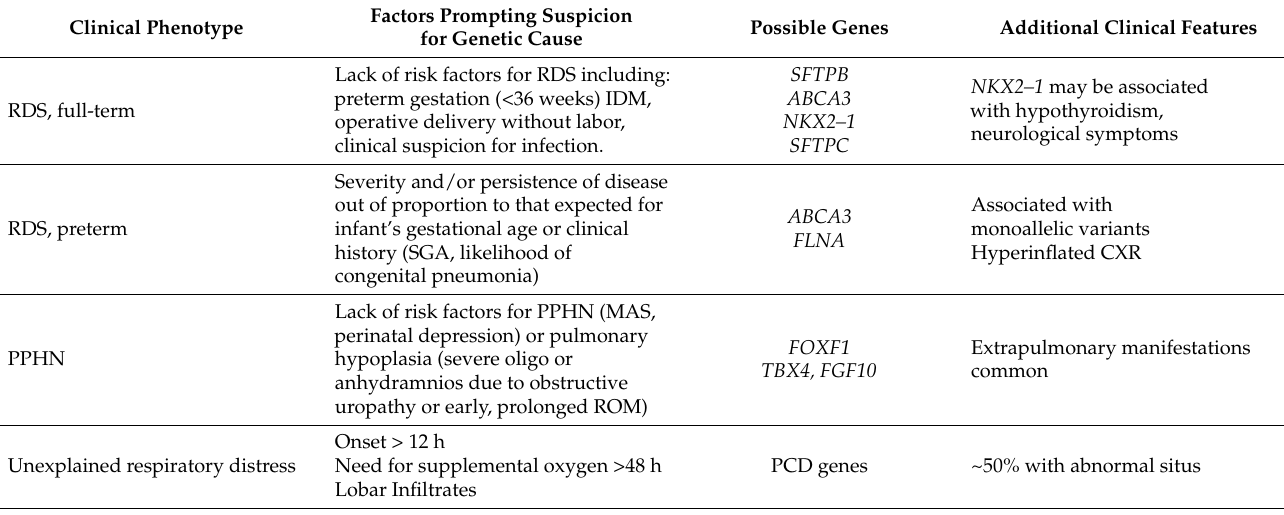
Table 3. Likely genetic mechanisms depending on neonatal clinical